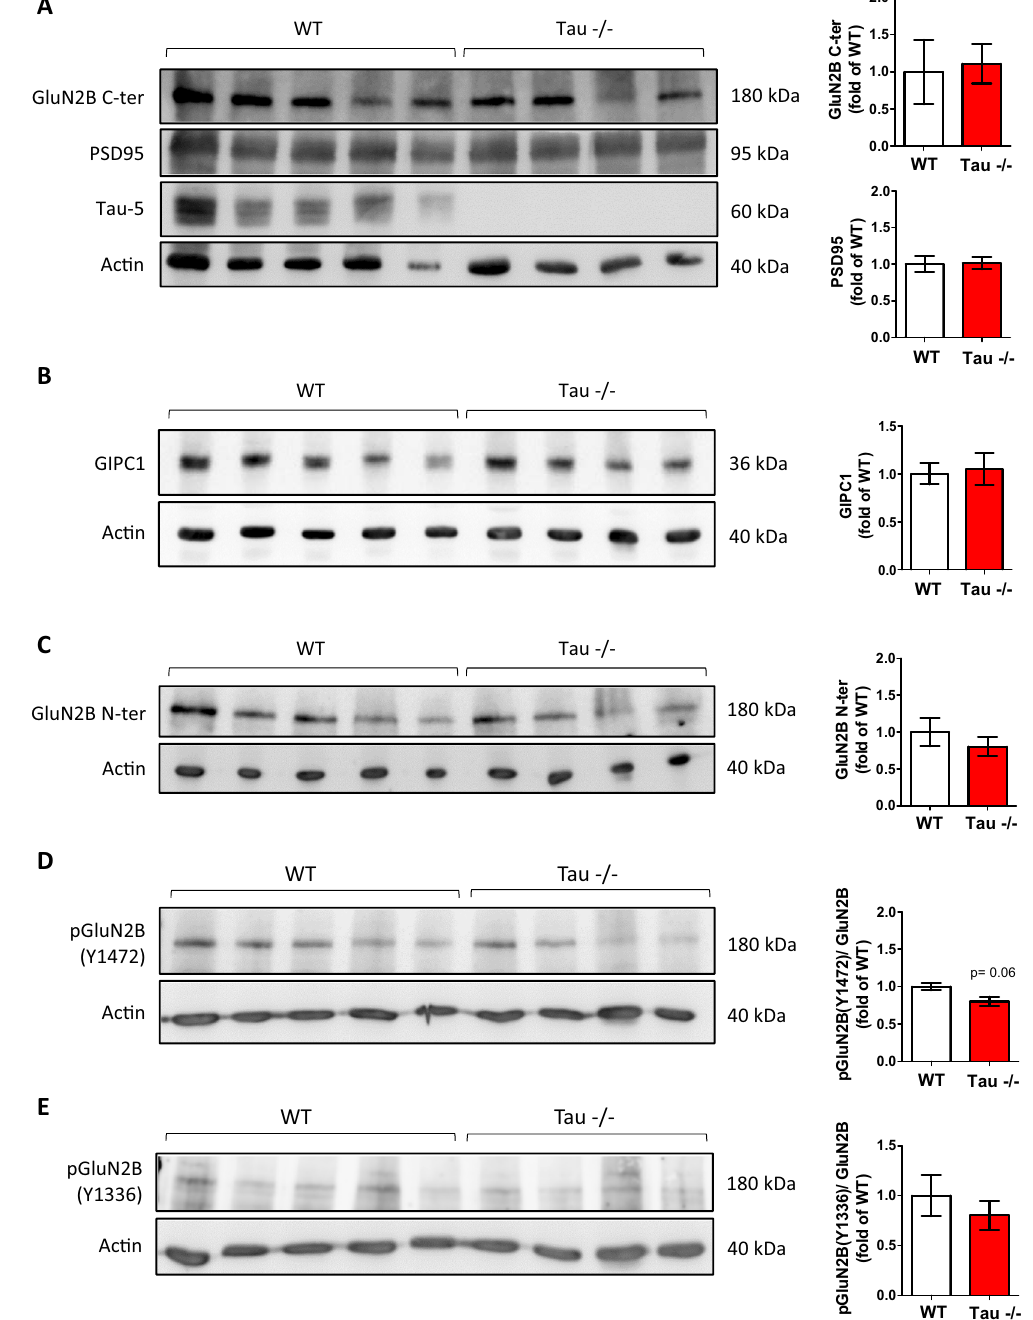
Figure 2. Absence of Tau does not alter NMDA receptor levels in synaptosome-enriched hippocampal fractions. Western blot (WB) analysis of the levels of Tau, PSD95, GIPC1 and GluN2B receptor subunits of NMDA receptors in synaptosome-enriched fractions obtained from the hippocampi of WT and Tau − / − mice. ( A ) Tau is not present in synaptosome-enriched fractions obtained from the hippocampi of Tau − / − mice, and this absence does not affect the levels of PSD95 or those of GluN2B subunits of NMDA receptors detected with an antibody directed against its C-terminus. Quantifications are shown on the right. ( B ) The levels of GIPC1 are not altered in Tau − / − synaptosome-enriched fractions as compared to WT ones. Quantification is shown on the right. ( C ) The levels of GluN2B subunits of NMDA receptors detected with an antibody directed against its N-terminus are not altered in synaptosome-enriched fractions of Tau − / − mice as compared to WT ones. Quantification is shown on the right. ( D ) The levels of GluN2B subunits of NMDA receptors phosphorylated at Y1472 (a phosphorylation occurring mainly at synaptic sites) tend to decrease in synaptosome-enriched fractions of Tau − / − mice as compared to WT ones. Quantification is shown on the right. ( E ) The levels of GluN2B subunits of NMDA receptors phosphorylated at Y1336 (a phosphorylation occurring mainly at extrasynaptic sites) are not significantly altered in synaptosome-enriched fractions of Tau − / − mice as